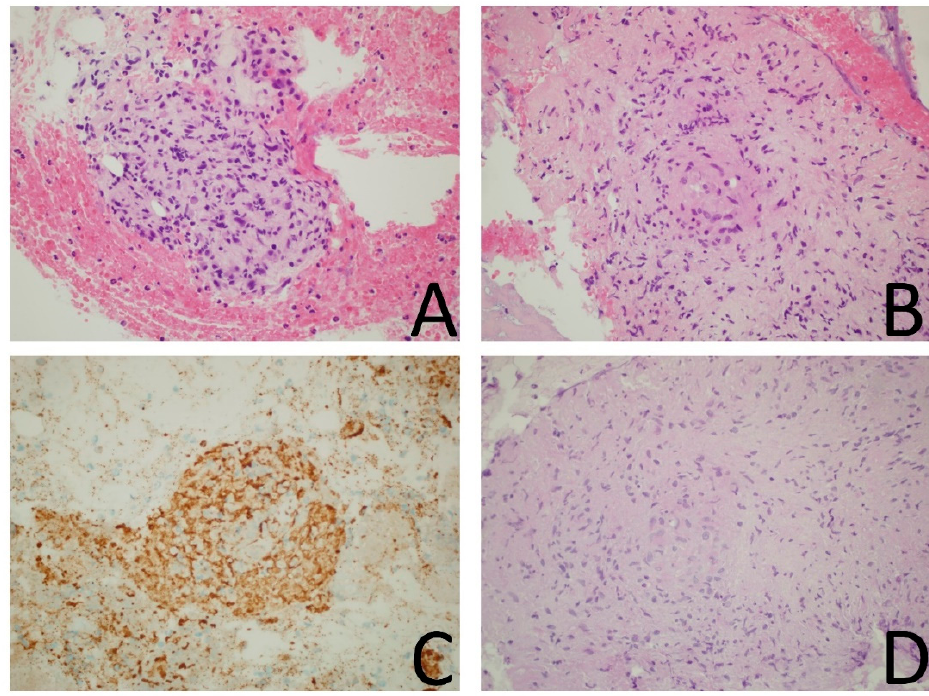
Figure 2. ( A , B ). Hematoxylin and eosin stain, original magnification 40 × . The specimen was characterized by abundant fibrinoid material with numerous erythrocytes and granulocytes and by granulomatous inflammatory infiltrates with a vaguely nodular pattern composed of histiocytes and multinucleated giant cells; ( C ). CD68 stain (clone PG-M1), original magnification 40 × . The histiocytes were highlighted by a CD68 stain. ( D ). Periodic acid–Schiff (PAS) stain, original magnification 40 × . PAS was negative for fungal organisms. The Ziehl–Neelsen stain was also negative for Mycobacteria (not shown).